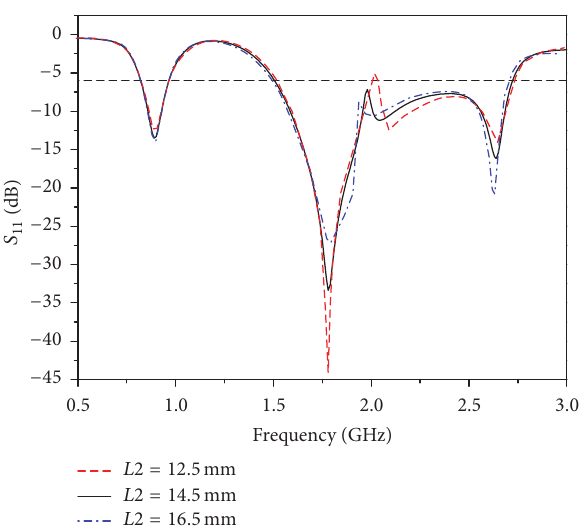
Figure 4: Reflection coefficient of the proposed antenna for different value of L 2.